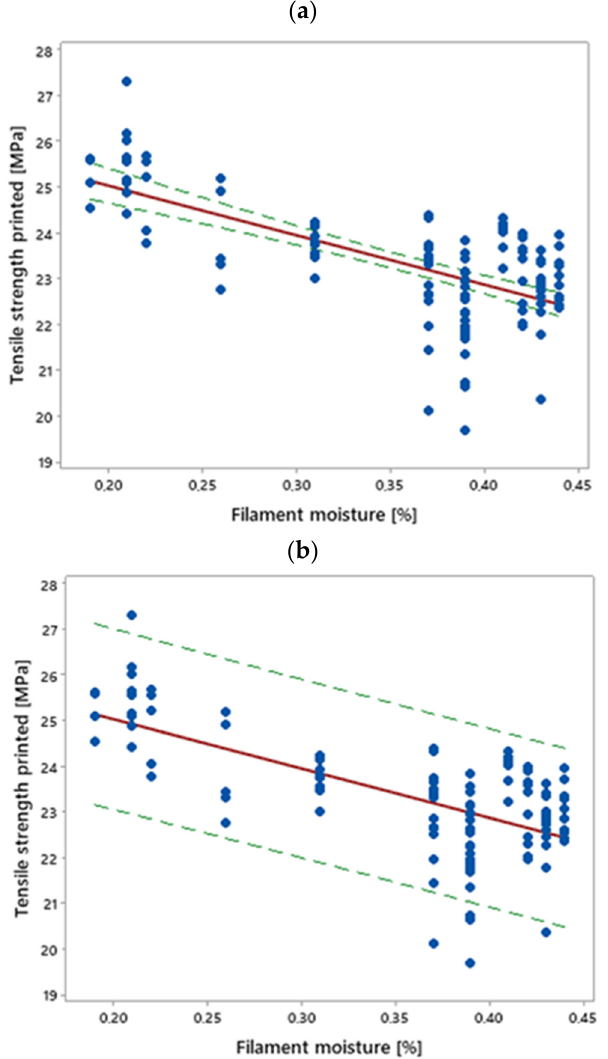
Figure 8. Regression line (red) between the tensile strength of the samples and the moisture of the filament (sample size n = 120): ( a ) with confidence interval (green) of the mean; ( b ) with prediction interval (green) for a single observation; confidence level = 0.95.